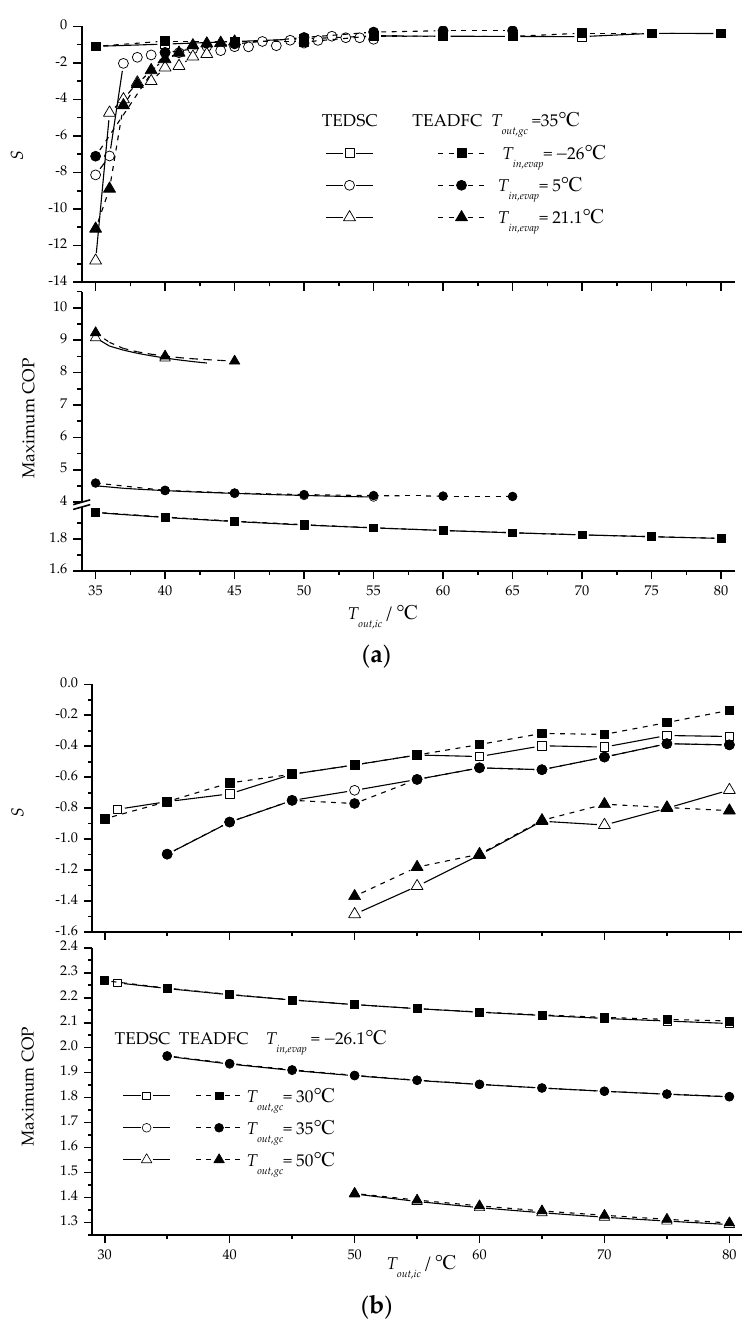
Figure 9. Sensitivity of maximum COP to temperature at intercooler outlet ( a ) different temperature at evaporator inlet; ( b ) different temperature at gas cooler outlet.